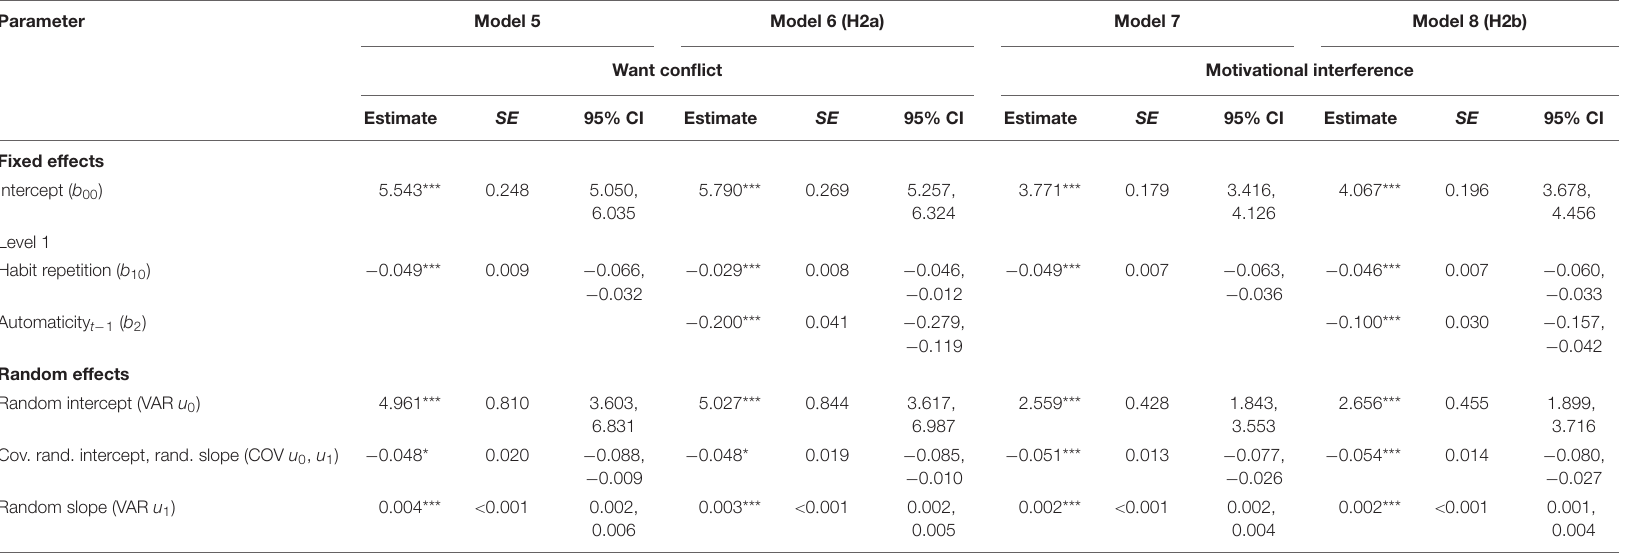
All estimated coefficients are unstandardized. Variables as specified in the model equations are in parentheses. CI, confidence interval; Automaticity t − 1 , automaticity value of the previous habit repetition; VAR, variance; COV, covariance; Cov. rand. intercept, rand slope, covariation of the random intercept and the random slope. *p < 0.05, ***p <